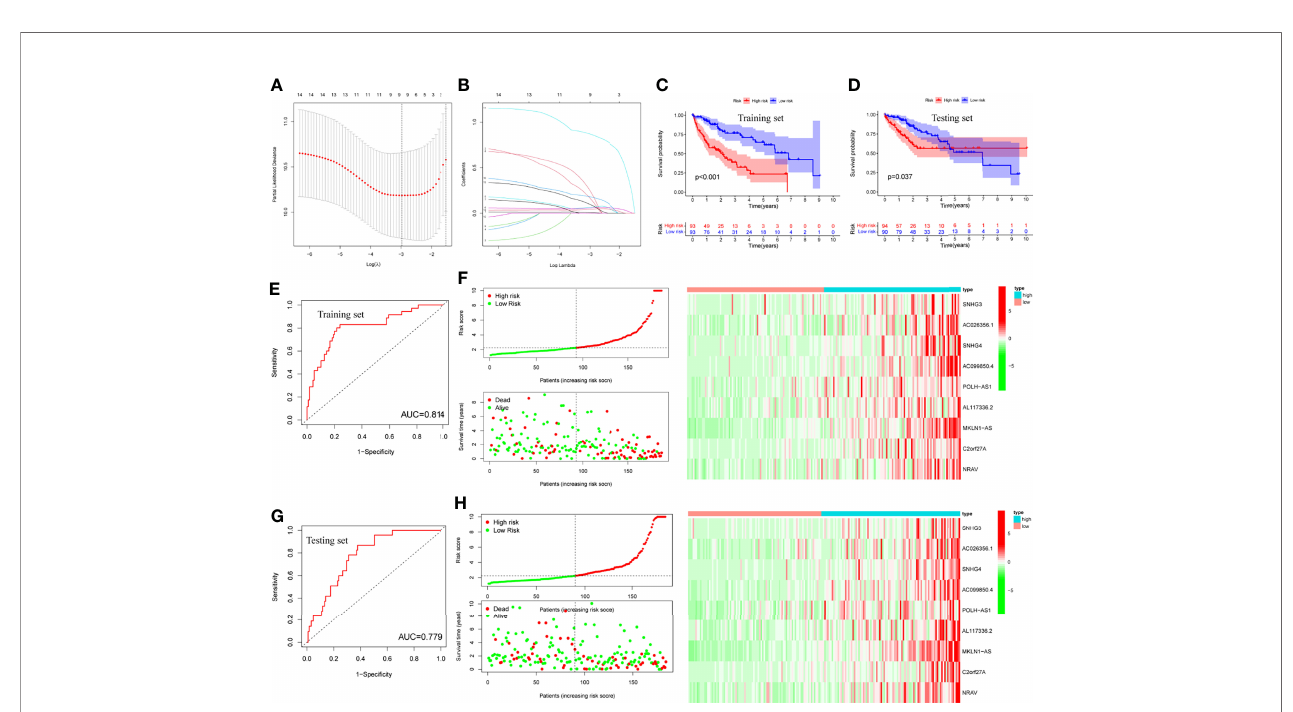
FIGURE 5 | LASSO regression, survival plots and risk score models. (A, B) LASSO regression plots, (C, D) Survival analysis of training and testing sets by risk groups, respectively, (E, F) Risk score model, ROC curve and heatmap of training set, (G, H) Risk score model, ROC curve and heatmap of testing